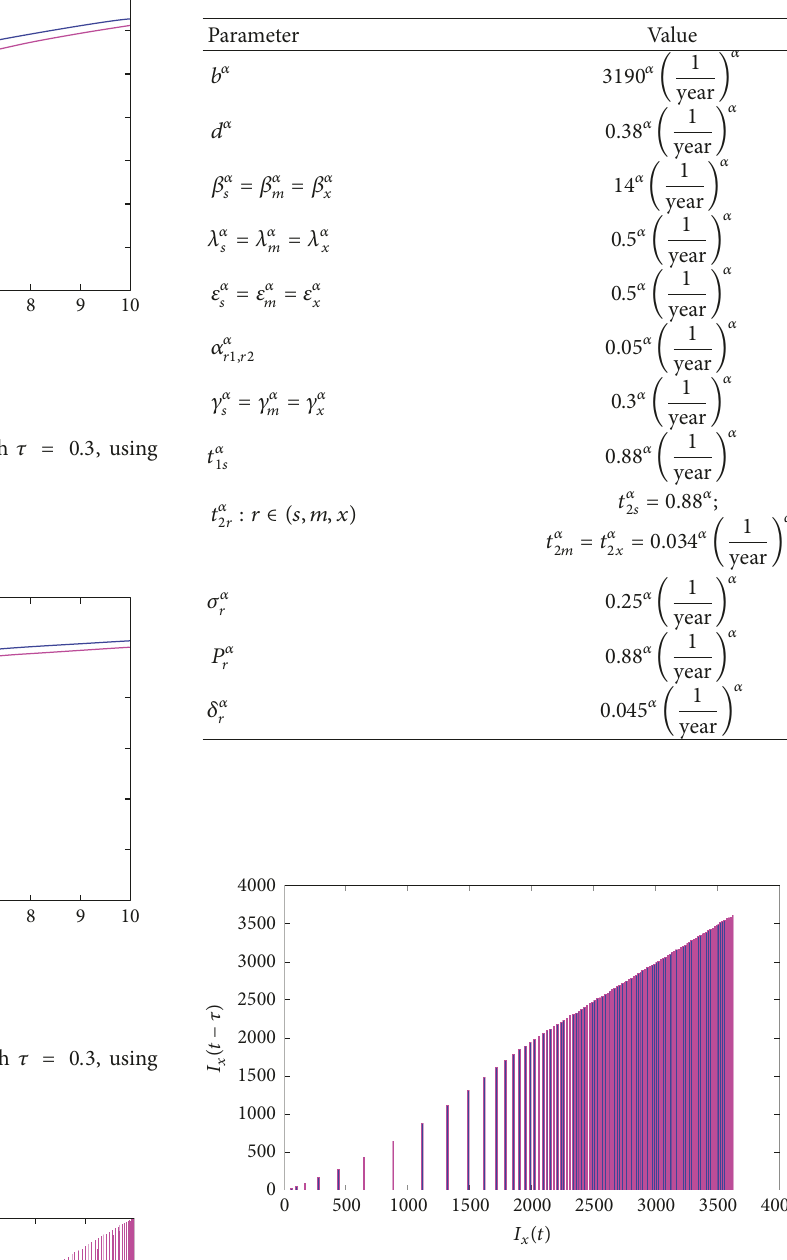
Table 3: Parameter values of system (1).